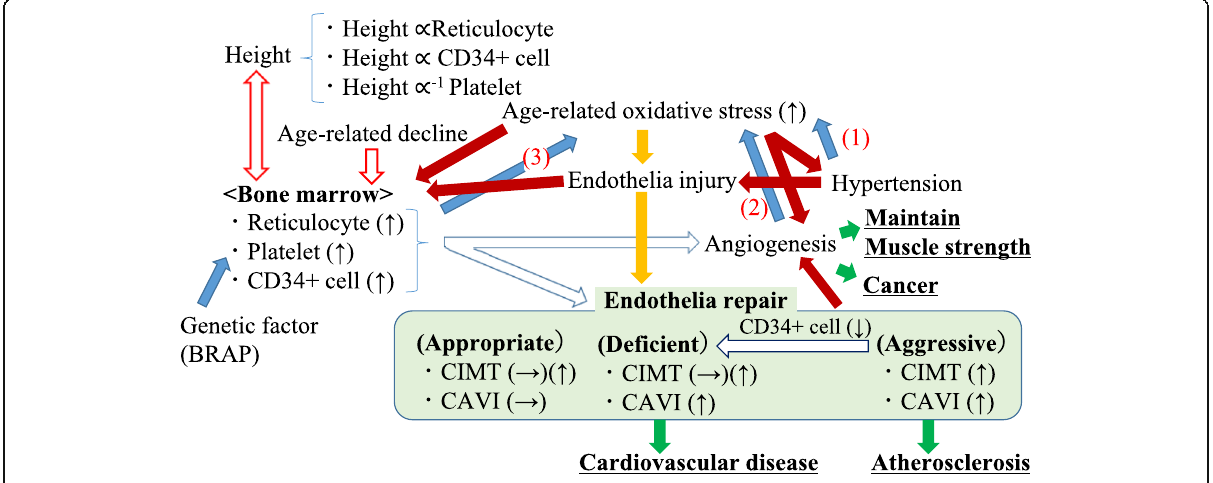
Fig. 5 Summary of potential mechanism underlying endothelial maintenance. CAVI, cardio-ankle vascular stiffness index; CIMT, carotid intima- media thickness. The pathway that reduces oxidative stress by hypertension (1), angiogenesis (2), and production of anti-oxidative agents